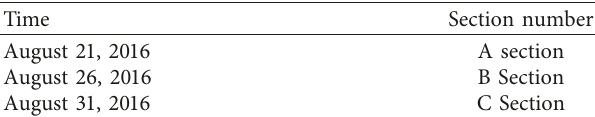
Figure 10: Schematic diagram of detection section site layout. Table 4: Detection sequence of roadway